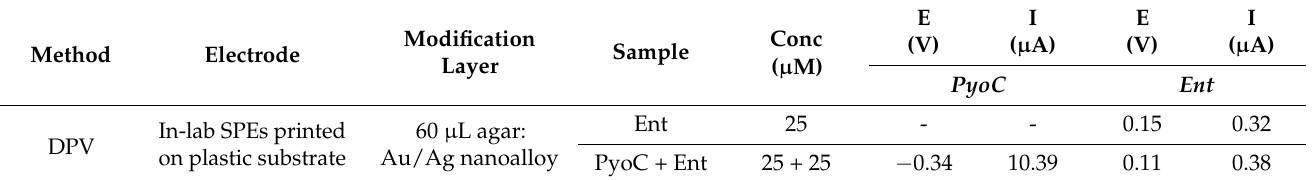
Table 3. Analytical parameters for Ent detection in 20 mM PBS pH 7.4 and in the presence of PyoC using in-lab printed